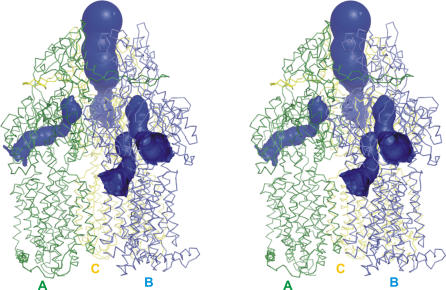
Channels in the AcrB TrimerStereo view of the channels leading through the periplasmic domain of AcrB. The structure of AcrB is shown as wire model and the DARPins omitted for clarity. The channels are shown as blue surfaces and were calculated using the program CAVER (http://loschmidt.chemi.muni.cz/caver).